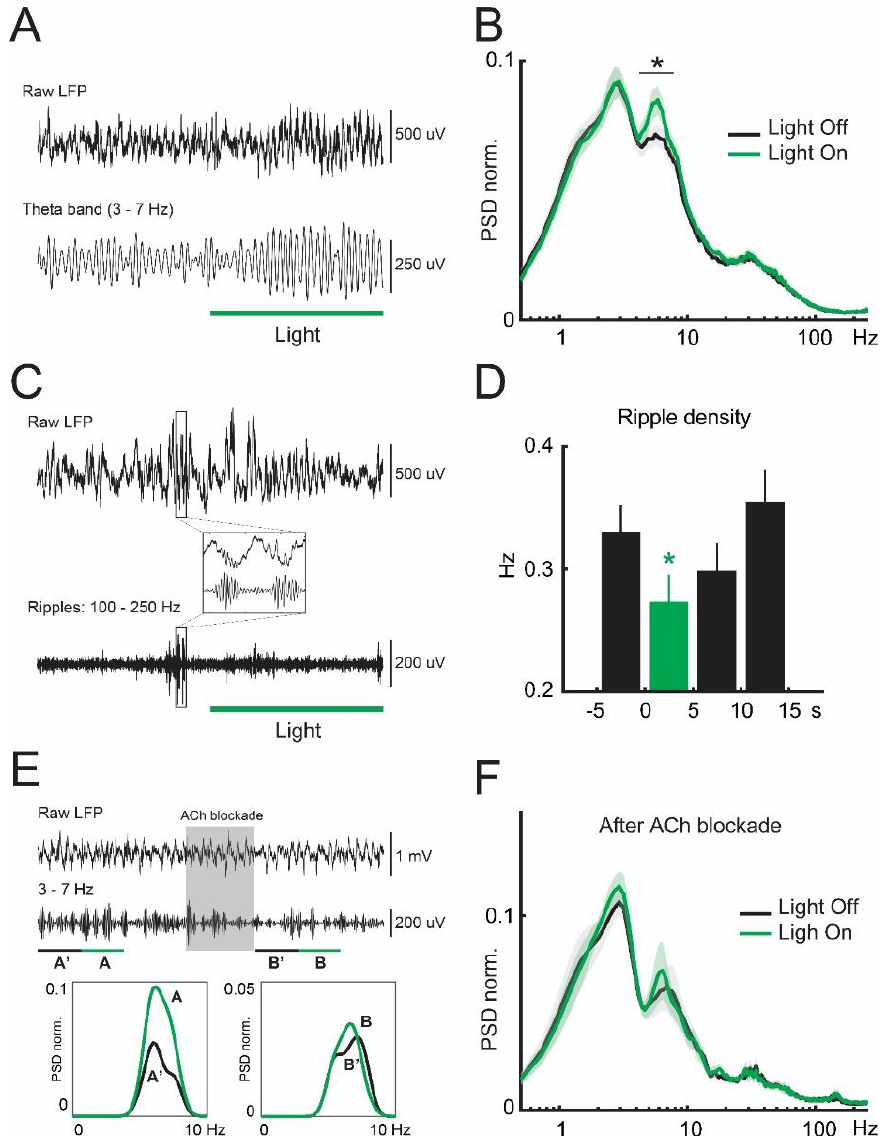
Figure 2. Theta oscillations and ripple density in the dorsal hippocampus during septal somatostatin cells inhibition. ( A ) Raw LFP (top panel), and theta-band-filtered LFP (3 − 7 Hz, bottom panel) for an example electrophysiological recording in the dorsal hippocampus (mouse NE113, recording 05, channel 29). ( B ) Average normalized power spectral density (PSD) of the dorsal hippocampal LFP in the presence (green line) or absence (black line) of optogenetic stimulation. Asterisk in band 4–7 Hz: paired t -test, p = 7.99 × 10 − 7 , n = 27 recordings. ( C ) Raw LFP (top panel), and ripple-band LFP (100 − 250 Hz, bottom panel) for an example electrophysiological recording in the dorsal hip- pocampus (mouse NE113, recording 05, channel 29). Inset, example sharp-wave ripple episodes before light stimulation. ( D ) Inhibition of septal somatostatin cells decreases ripple density (green bar, mean value ± SEM, bin = 5 s). Asterisk: one-way ANOVA test, and Bonferroni post-hoc correction, p = 0.0131, n = 262 trials. ( E ) Example electrophysiological recording (mouse NE125, recording 03, channel 20) showing response patterns before and after drug administration (gray box). From top to bottom: raw LFP, theta-band-filtered LFP, and PSD during control (black line) and optogenetic stimu- lation (green line). ( F ) Average normalized power spectral density (PSD) of the dorsal hippocampal LFP after cholinergic receptors